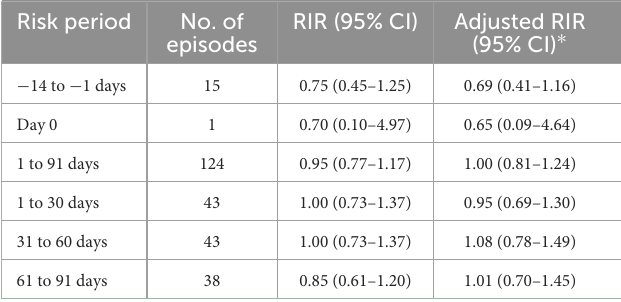
TABLE 2 The relative incidence ratio of PFP after IIV3